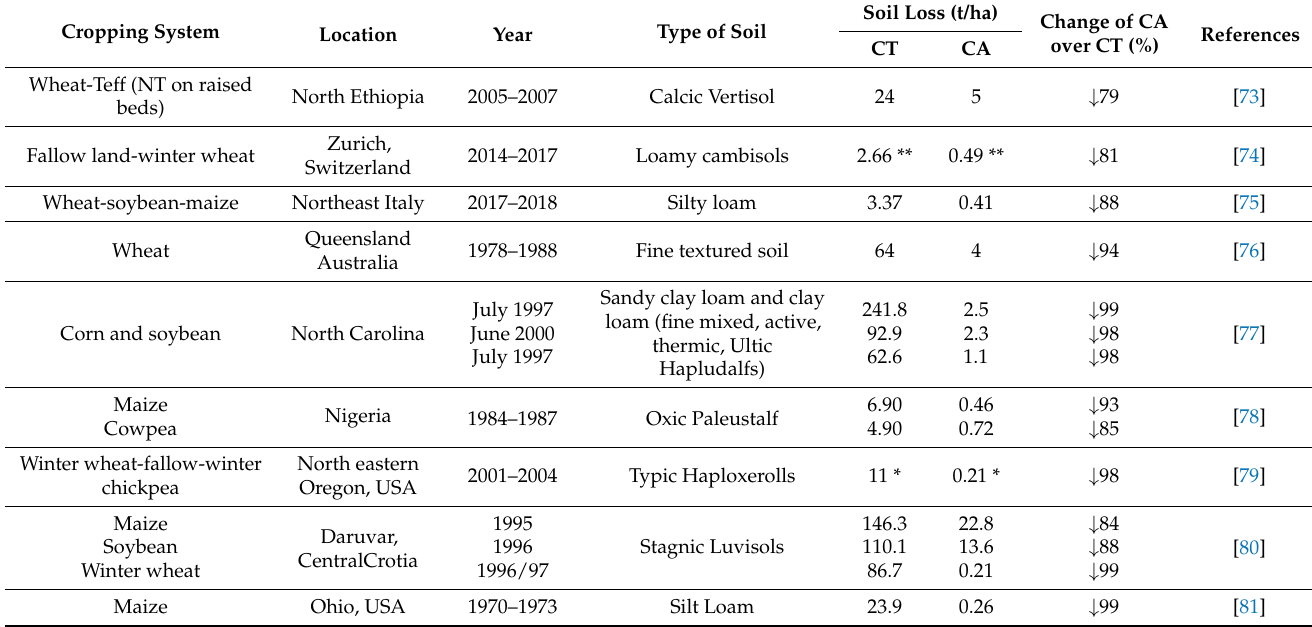
Table 2. Comparison of conservation agriculture (CA) and conventional tillage (CT) on soil loss (t/ha). Cropping System